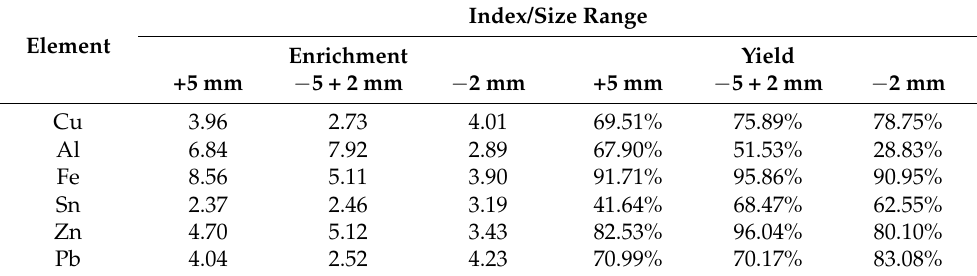
Table 5. Evaluation indexes of the separation of main metals contained in the wasted PCBs.